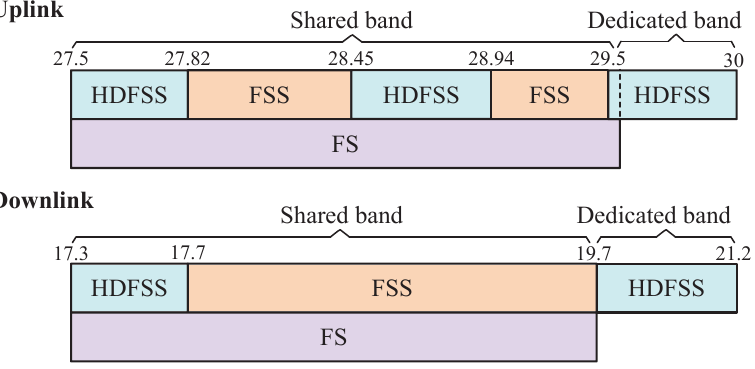
Figure 2. Spectrum coexistence of fixed satellite service (FSS) and high-density FSS (HDFSS) with fixed service (FS) in the Ka